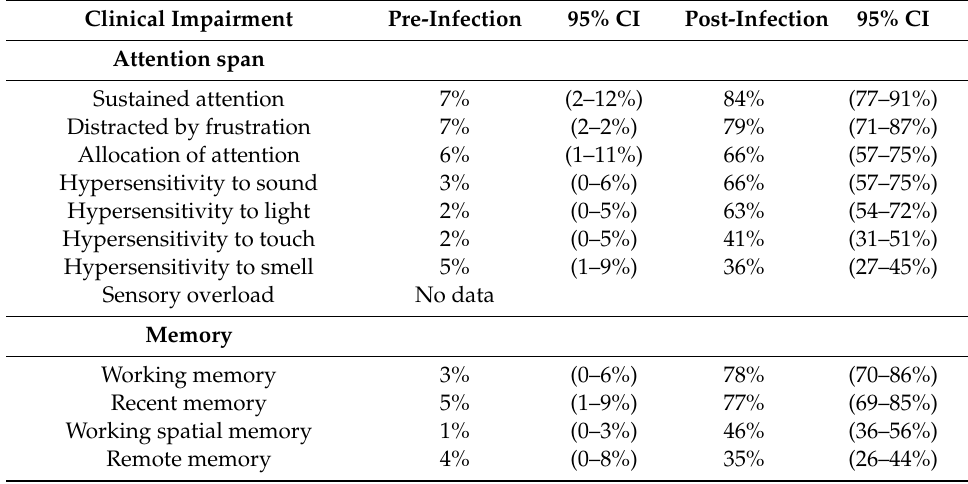
Table 1. The full assessment list includes clinical findings that are statistically significant pre- vs.- post-infection, not statistically significant pre- vs. post-infection and without statistical